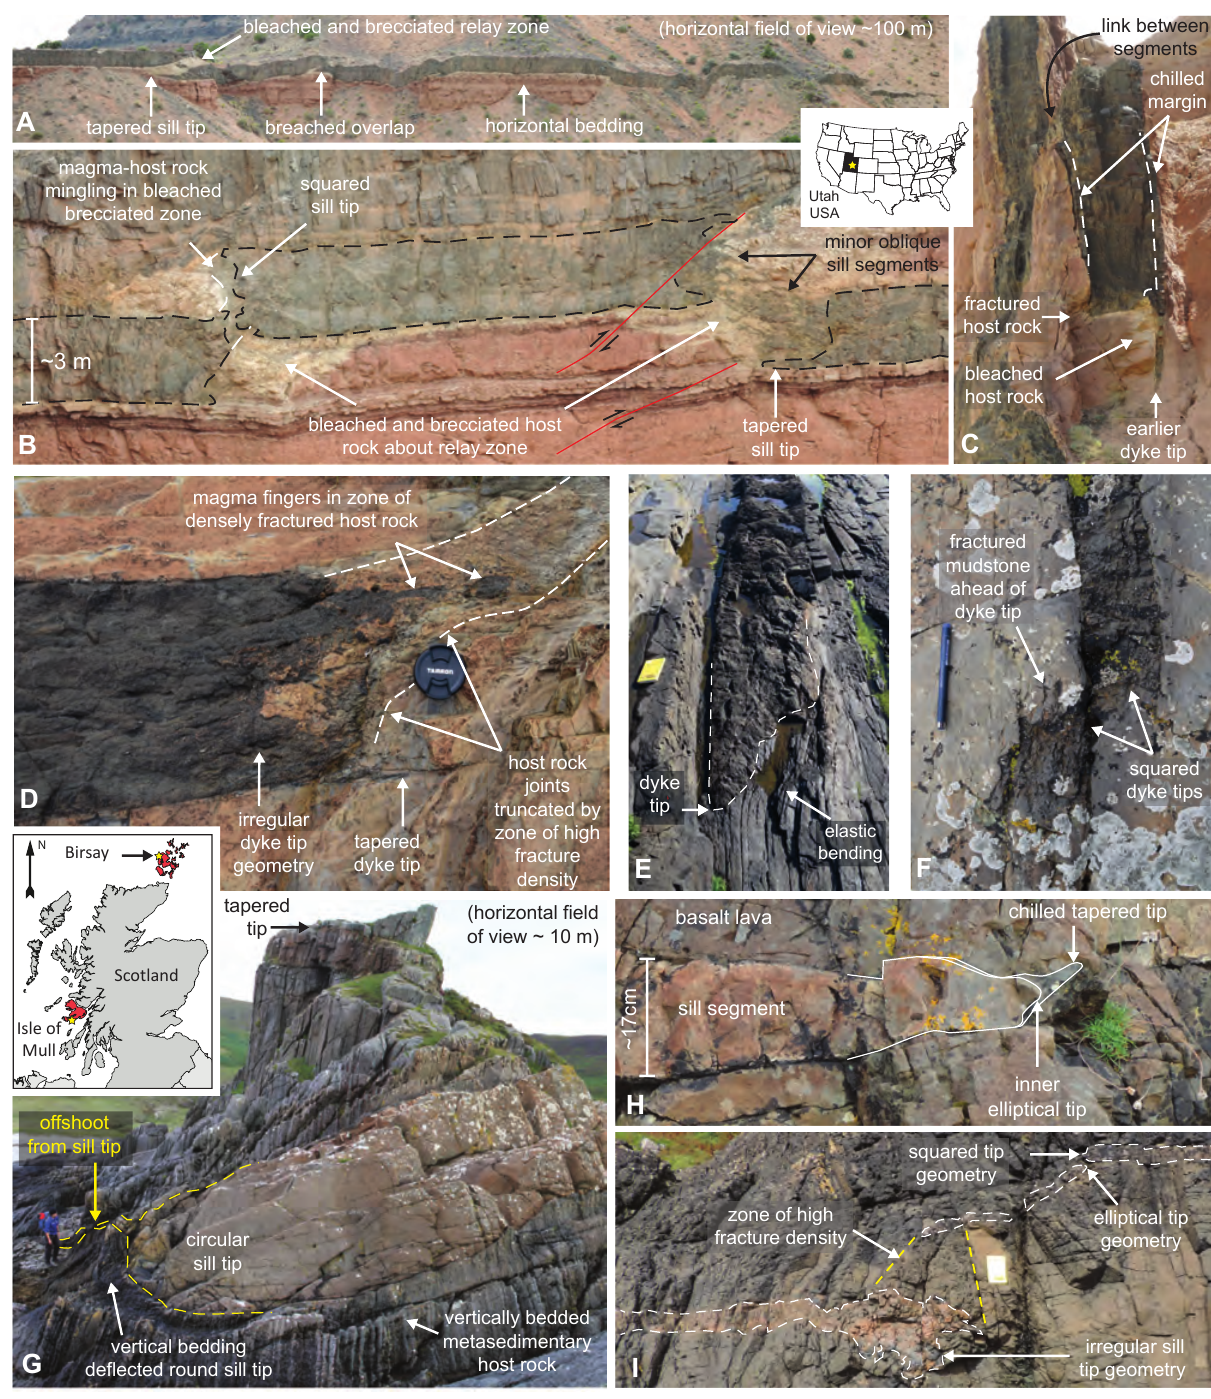
Figure 2: Field examples of tapered to squared sheet intrusion tip geometries. [A]–[C] Basaltic intrusions in hor- izontal interbedded sandstone-shale sequences, San Rafael Subvolcanic Field, Utah, USA: [A] sill segments with tapered tips; [B] sill segments with squared and tapered tips; [C] dyke segment with tapered and squared tip. [D]– [F] Basaltic dykes in siltstone and mudstone, Birsay, Orkney, UK: [D] dyke in siltstone with irregular tip geometry, magma fingers intrude the highly fractured zone ahead the dyke tip, lens cap for scale. [E] Dyke in mudstone, joint traces curve around, and are truncated by, the asymmetrical tip, notebook for scale. [F] Underlapping dyke seg- ments in mudstone, locally fractured host rock ahead of squared tips, pen for scale. [G]–[I] Basaltic sill segments, Isle of Mull, UK. [G] Sill segments with circular and tapered tips in vertically bedded metasedimentary host rock. [H] Sill segment with tapered tip in basaltic lava. [I] Sill segment with irregular tip geometry associated with a zone of densely fractured basaltic lava. (Field locations, additional examples, and unannotated photos are available in Supplementary File